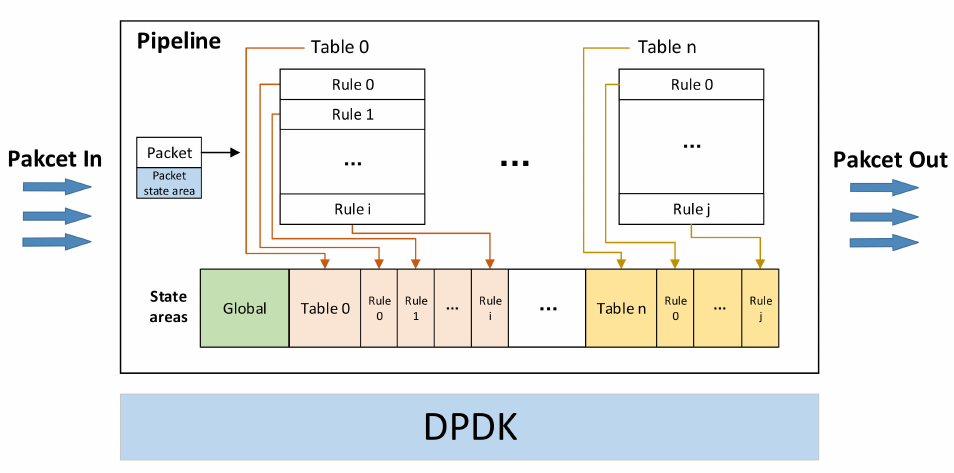
Figure 9. Pipeline architecture based on the DPDK framework that uses MSSA to record